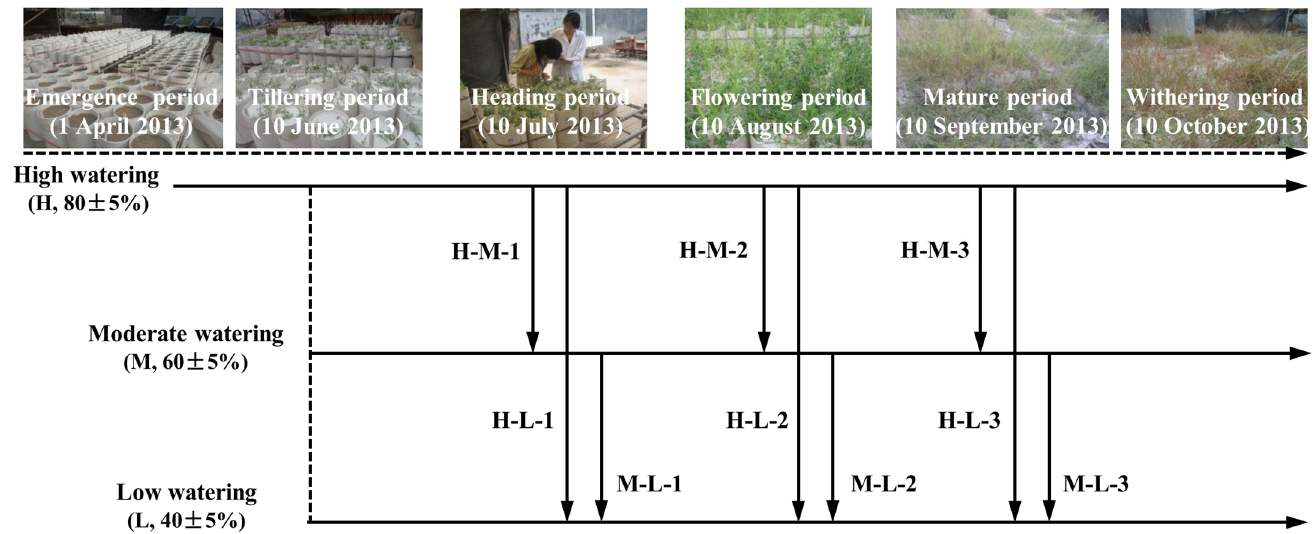
Figure 1. Scheme of periodical soil water decreasing treatments during different growth stages of Bothriochloa ischaemum. H: 80 ± 5% field capacity (FC); M: 60 ± 5% FC; L: 40 ± 5% FC; H-M-1, H-M-2, and H-M-3 or H-L-1, H-L-2, and H-L-3: soil water content decreased from H to M/L during